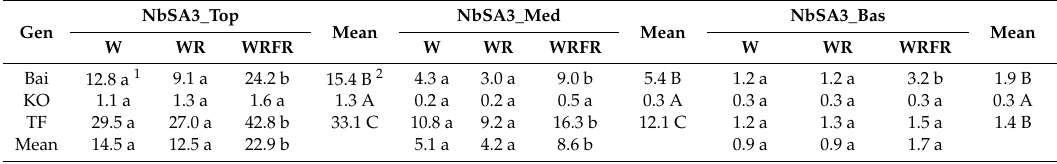
Table 7. Least-square means (LS means) of branching variables measured on the order 2 axes at measurement point 2 for Baipome (Bai), Knock Out ® Radrazz (KO) and ‘The Fairy’ (TF) grown in a climatic chamber under three light conditions: W, WR, and WRFR.